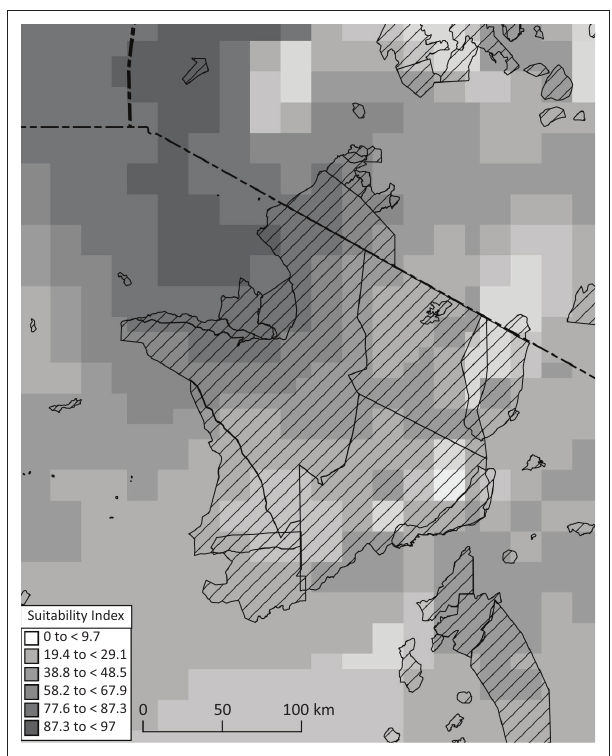
e f Grey shading depicts the Eco-climatic Indices (suitability of each location); the darker the shading, the more suitable the climate in that area is for Parthenium hysterophorus to establish and proliferate. FIGURE 5: CLIMEX generated map of the relative climatic suitability of the Serengeti-Mara ecosystem and surrounding areas for Parthenium hysterophorus based on a model developed by McConnachie et al.